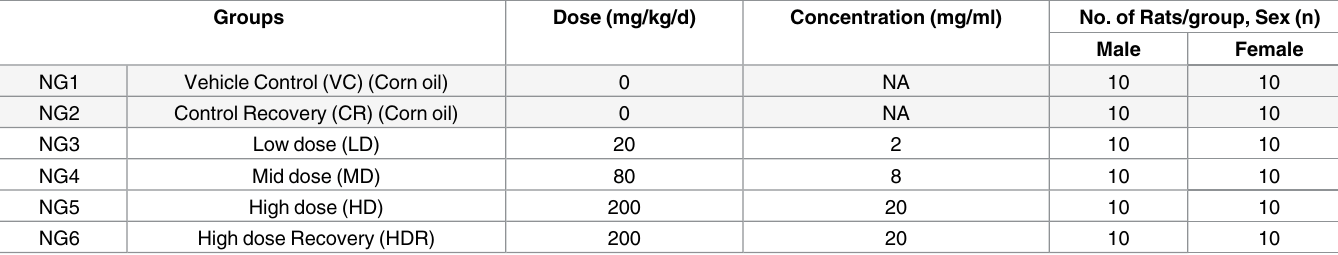
Table 1. Dosage groups for repeated dose 90 day oral toxicity study in SD rats.